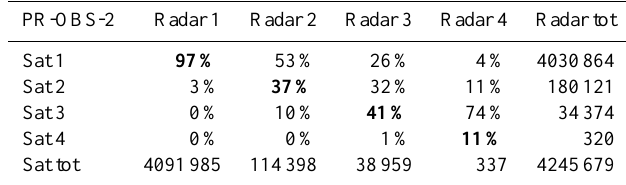
Table 9. Contingency table for the multi-categorical statistics for PR-OBS-1 as compared with radar-derived rain fields.